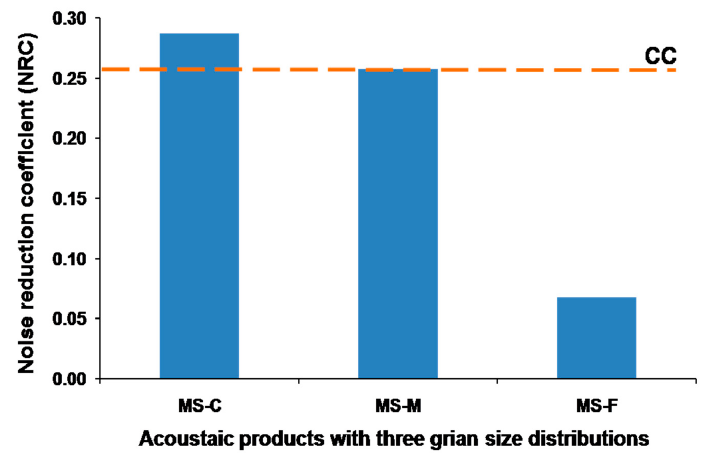
Figure 7. Noise reduction coefficients (NRCs) of the three acoustic products compared with coarse porous cement (CC).